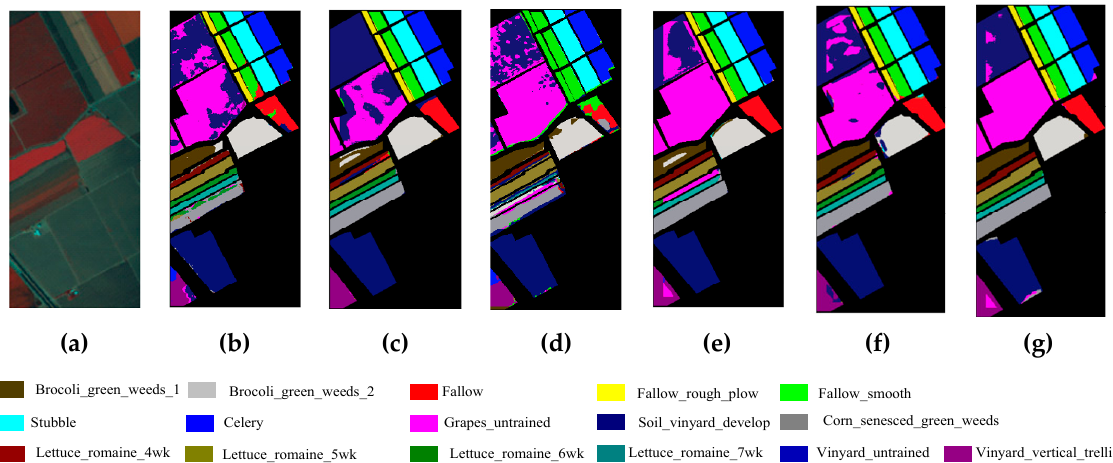
Figure 13. Salinas. ( a ) False-color composite image. The classification maps using ( b ) EMP-SVM; ( c ) CNN; ( d ) SSRN; ( e ) VGG; ( f ) SST-FA; ( g ) T-SST-L.